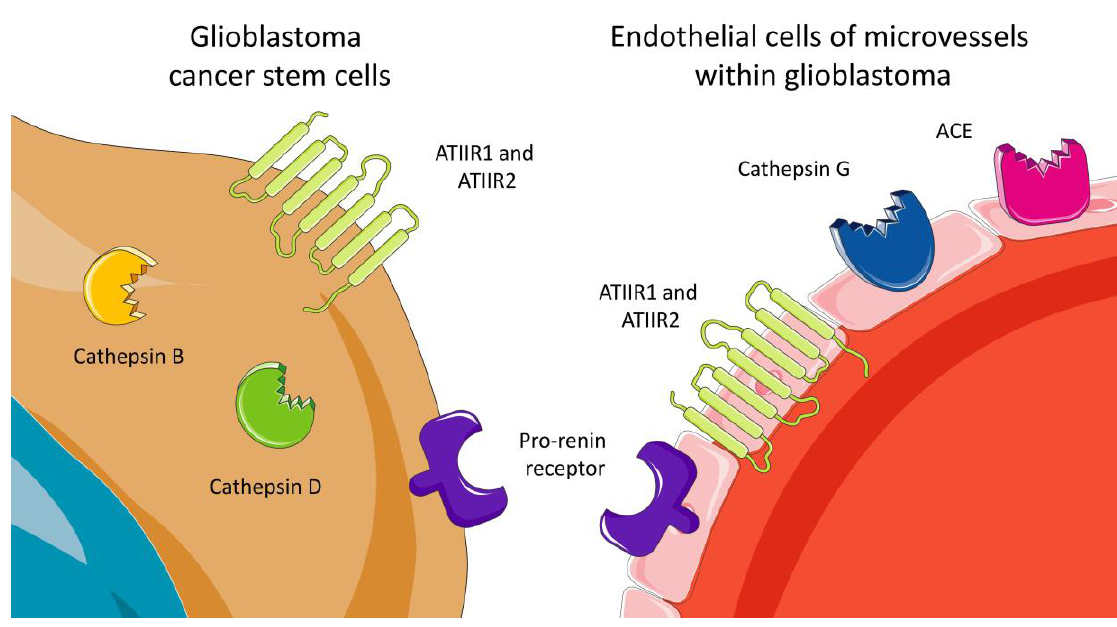
Figure 2. Expression of components of the renin-angiotensin system and proteins that constitute bypass loops of the renin-angiotensin system by cancer stem cells and the microvessels within glioblastoma. Cancer stem cells in glioblastoma express ATIIR1, ATIIR2, pro-renin receptor, cathepsin B and cathepsin D. The endothelium (pink cells) on the microvessels within glioblastoma express ACE, ATIIR1, ATIIR2 and cathepsin G.